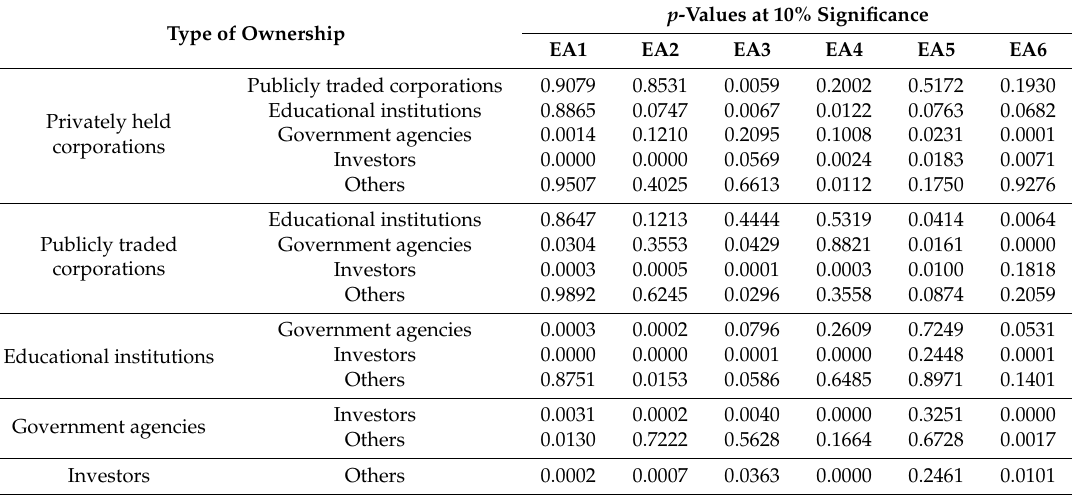
Table 7. Post-hoc test Bonferroni Mann–Whitney U test